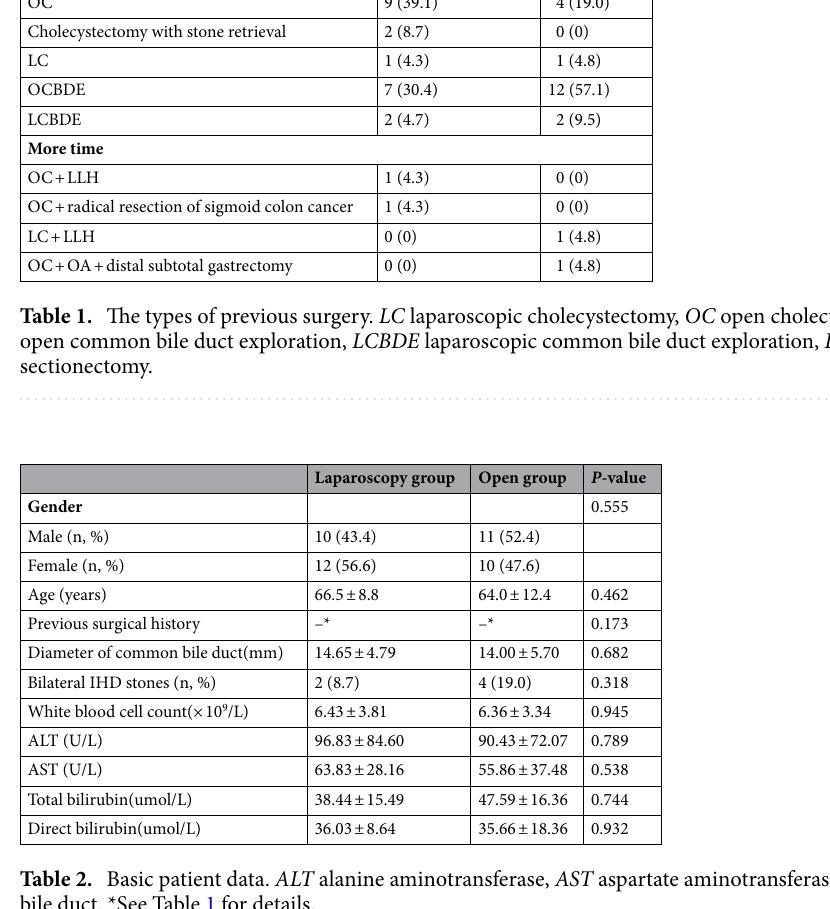
Table 2. Basic patient data. ALT alanine aminotransferase, AST aspartate aminotransferase, IHD intrahepatic bile duct. *See Table 1 for details.